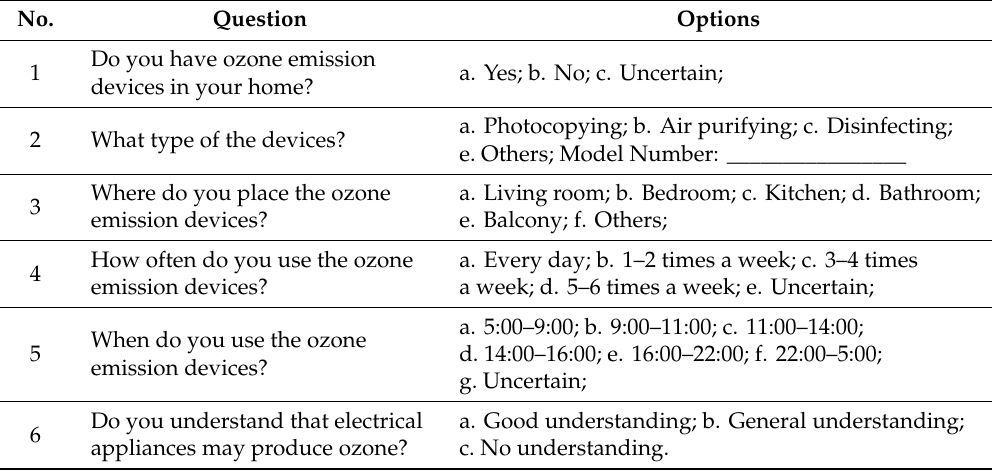
Table 2. Questionnaire survey on indoor ozone emission